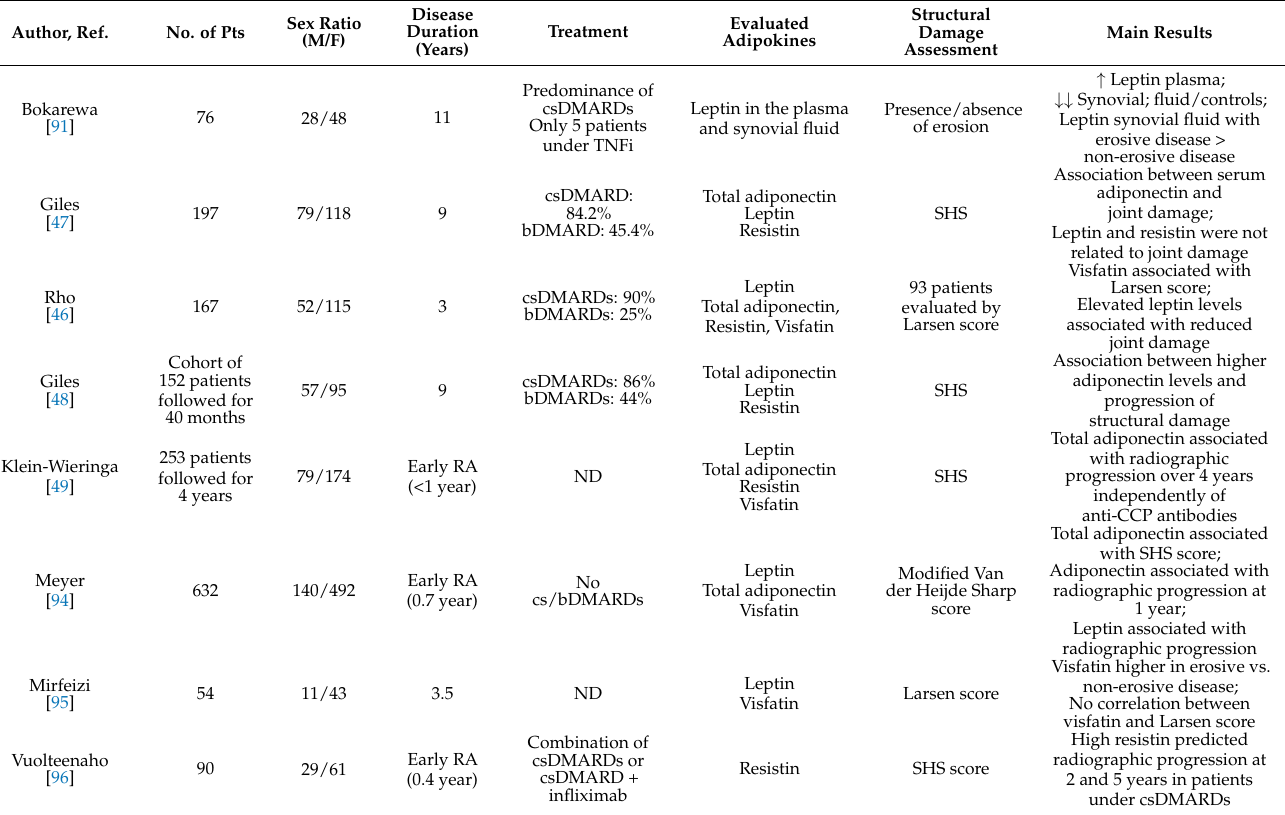
Table 1. Relationships between adipokines and radiographic damage in rheumatoid